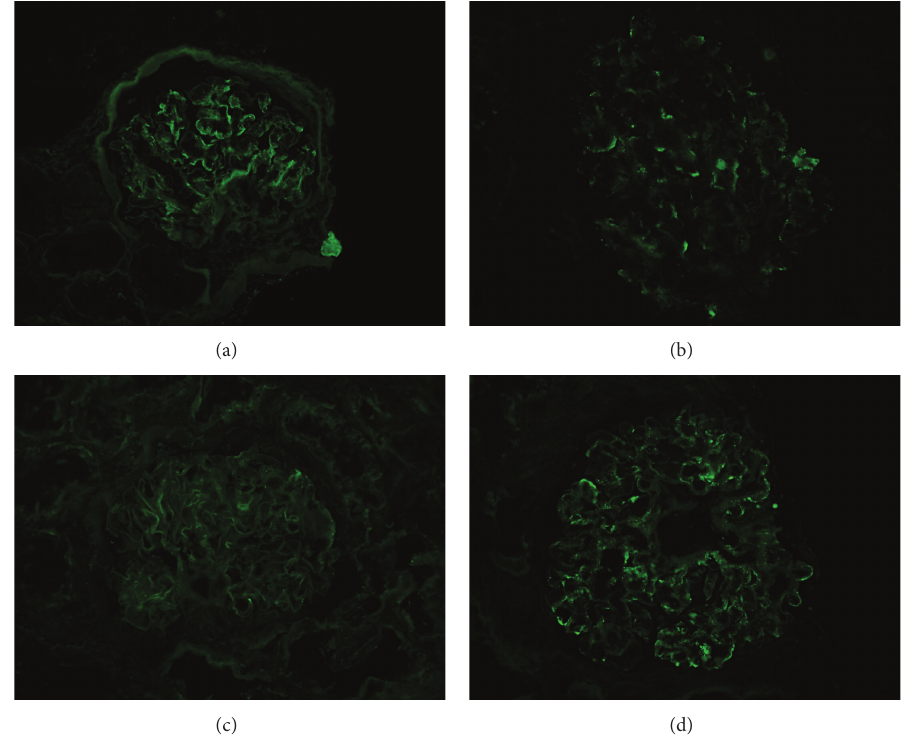
Figure 3: Immunofluorescence staining of kidney biopsy. Immunofluorescence staining shows trace mesangial staining for IgG (a), IgM (b), and kappa light chain (c) but 2+ mesangial and granular capillary loop staining for lambda light chain (d), confirming the diagnosis of PGNMID with monoclonal lambda light